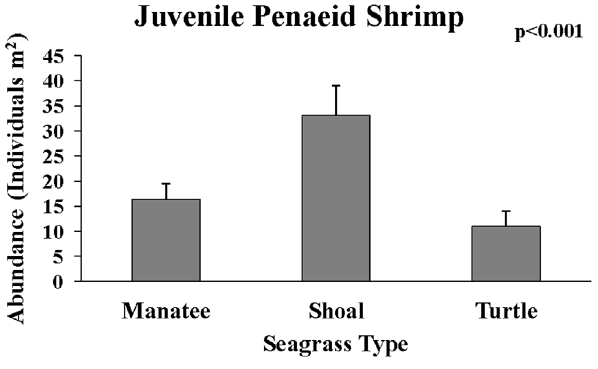
Figure 6. Mean ( + SE) of blue crabs collected in each seagrass species.